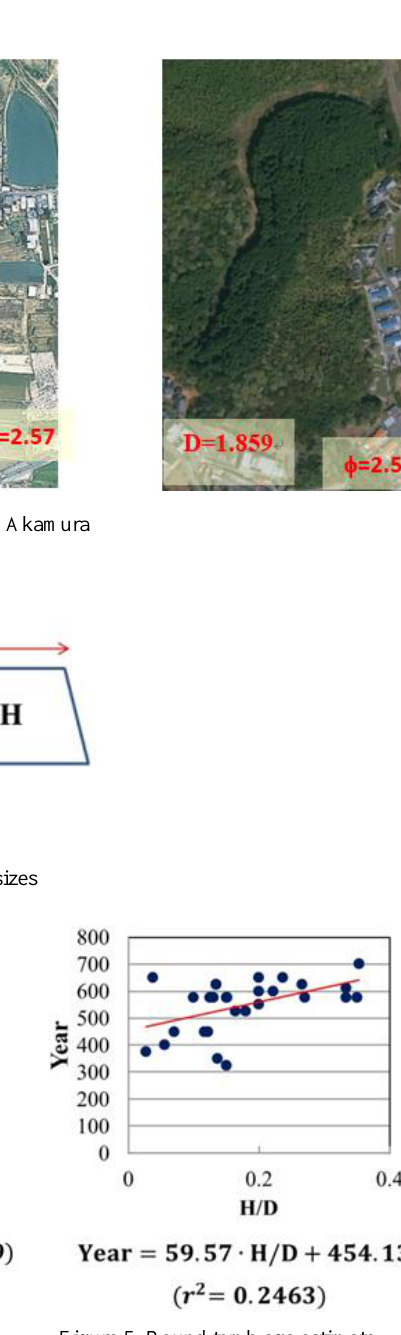
Figure 3. Keyhole tomb size correlation Figure 4. Keyhole tomb age estimate Figure 5. Round tomb age